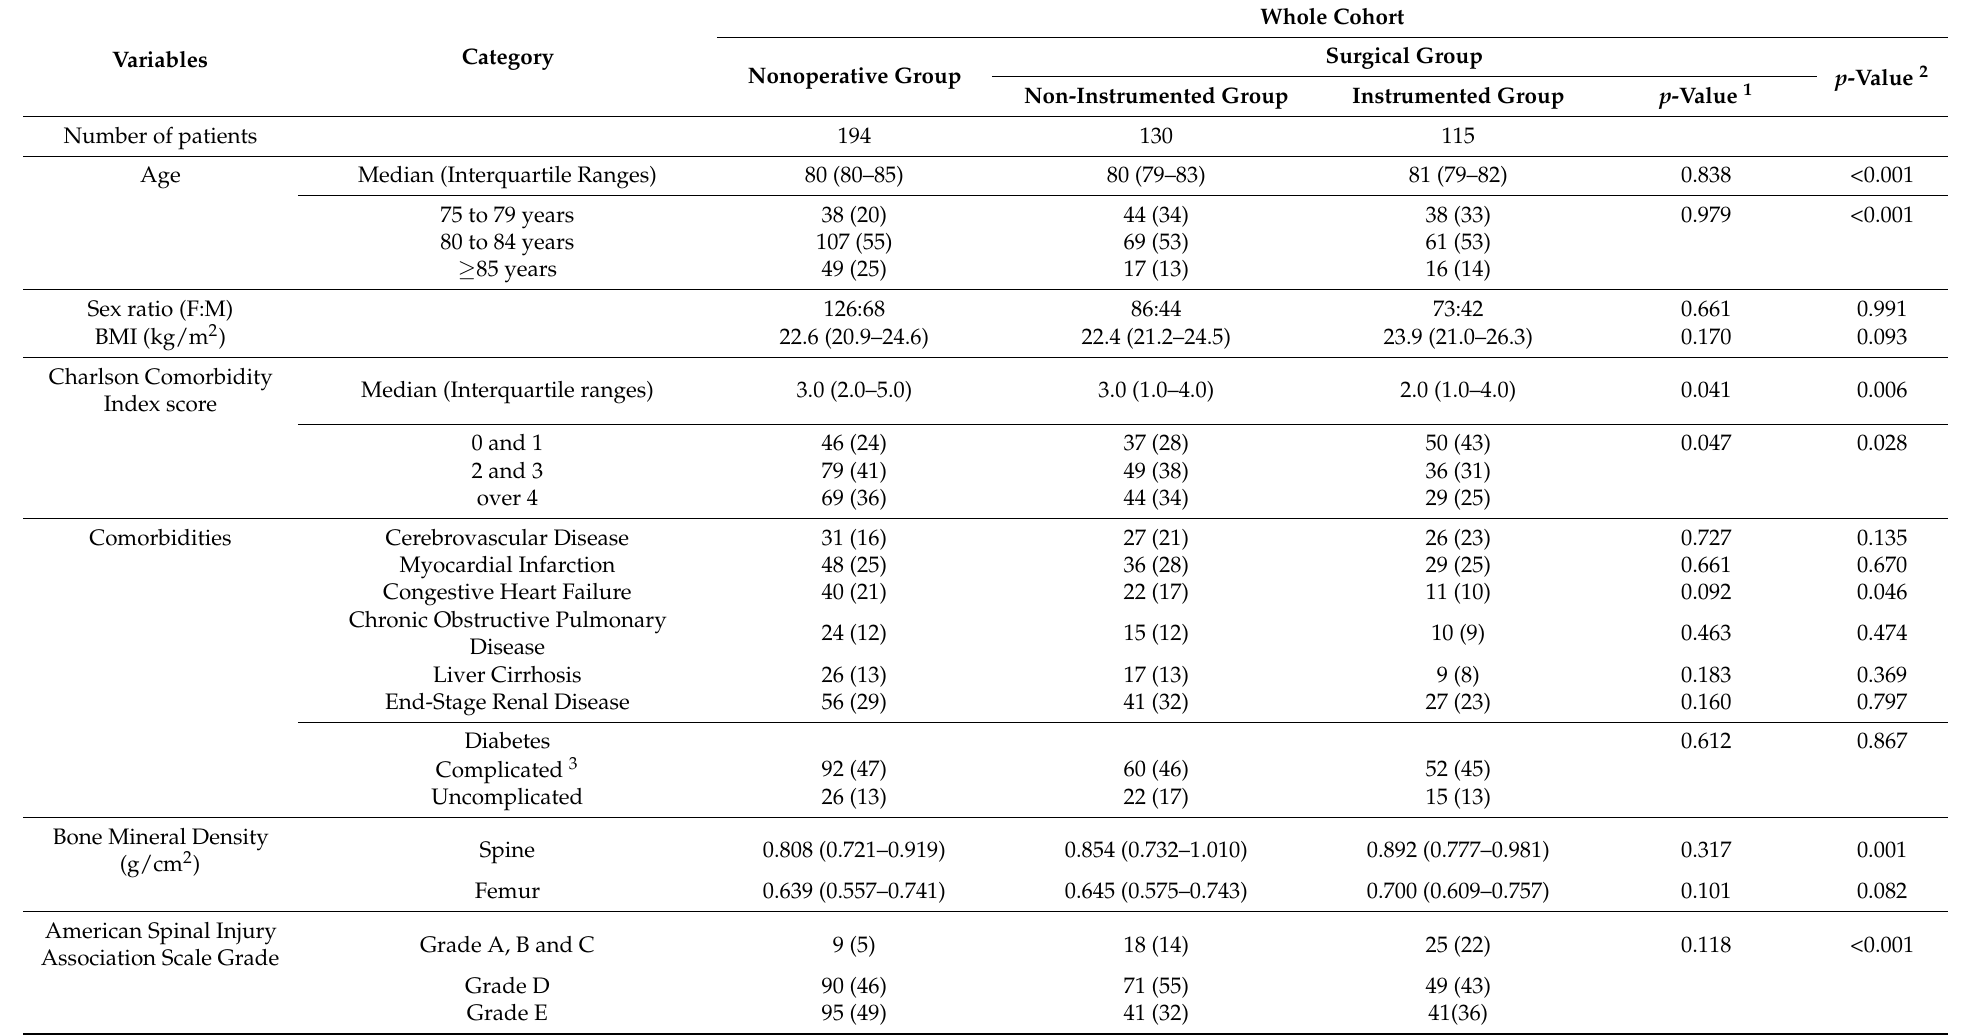
Table 1. Comparison of baseline patient characteristics among the three